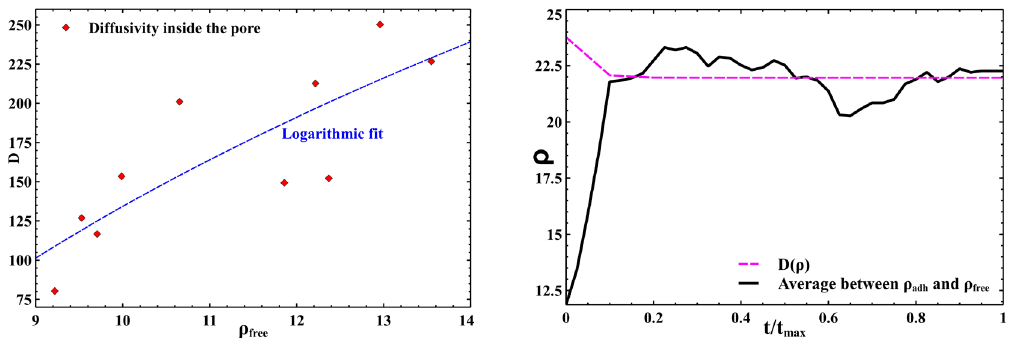
Figure 2. Time dependence of the densities averaged over the pore volume (left) and densities averaged over two central layers of the inner space of the pore (right). ρ is the density of the water vapour in [ng / nm 3 t max = 16663 . 2ps. Figure 1. Geometrical configuration of the molecular dynamics model of the through-type pore.